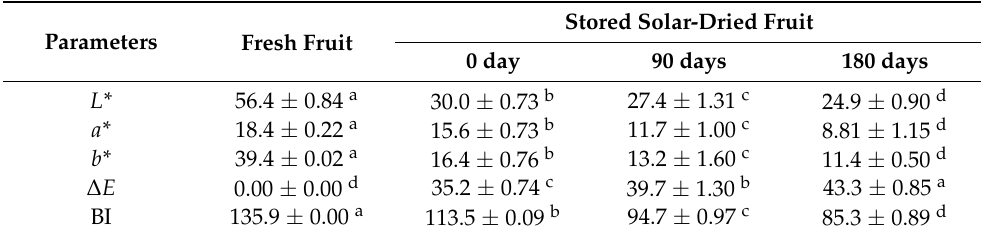
Table 3. Color values of fresh and solar-dried tomato